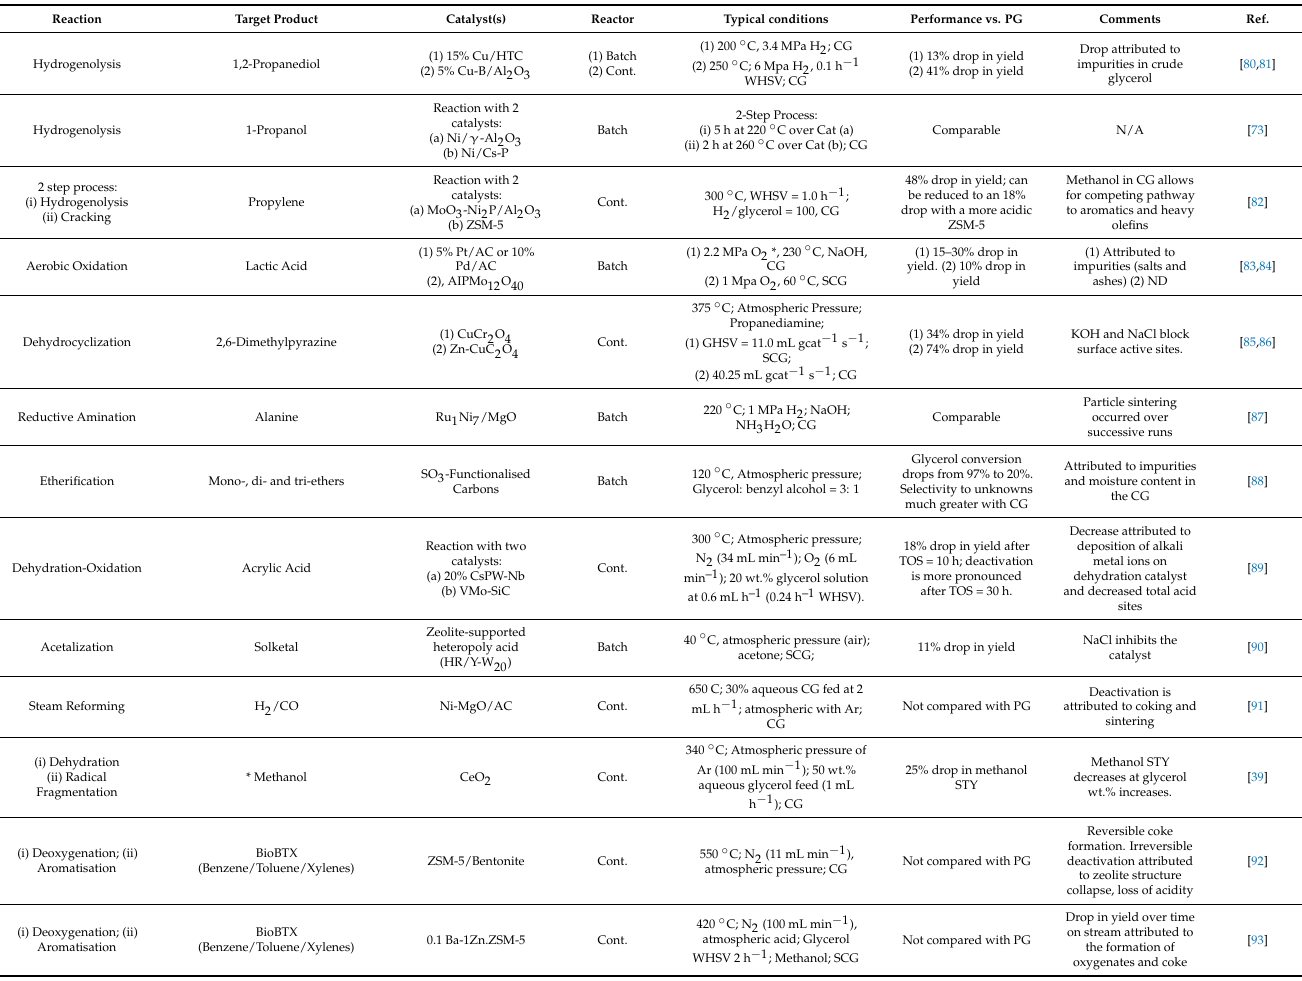
Table 3. List of published transformations (2017 onwards) where crude glycerol (CG) or synthetic crude glycerol (SCG) is used as a